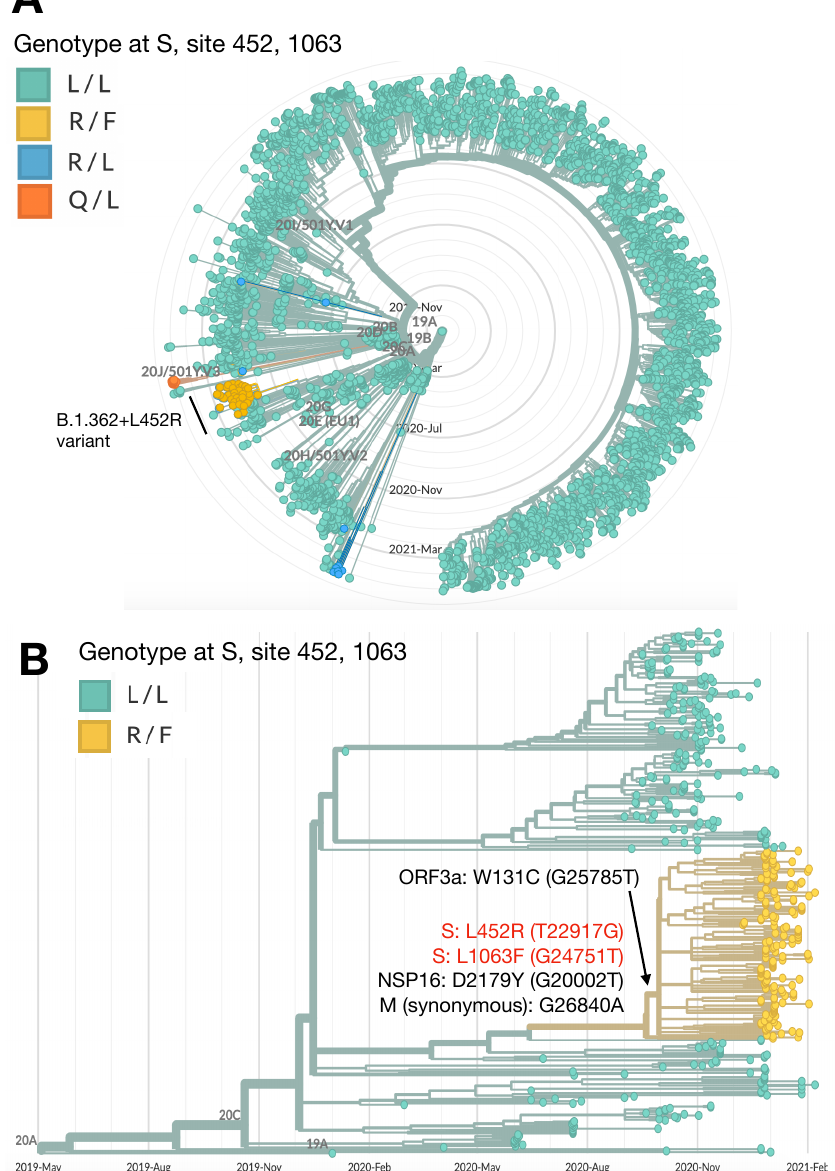
Figure 1. Characterization of the B.1.362+L452R variant in Israel and within the global B.1.362 lineage. ( A ) Phylogenetic tree representing random samples sequenced in Israel from December 2020 to May 2021 ( n = 3870). The genotype at the S protein in locations 452 and 1063 is indicated, with the different amino acid substitutions in these locations denoted by different colors: wild type in green (L/L: positions 452 and 1063 are Leucine (L)) and B.1.362+L452R variant in yellow (R/F: positions 452 and 1063 were substituted to arginine (R) and phenylalanine (F), respectively). Additional variants which have a mutation in the 452 positions are apparent in the tree, including a B.1.617.2 variant cluster with R/L in blue and a C.37 variant cluster with Q/L in orange. ( B ) Global SARS-CoV-2 genomes from of the B.1.362 lineage only ( n = 441). The wide type genotype (L/L) is indicated in green and the B.1.362+L452R variant cluster (R/F) in yellow. The B.1.362+L452R variant cluster is composed of Israeli viruses only. Phylogenetic trees were created with Nextstrain Augur pipeline and visualized with Auspice [26]. Non-Israeli B.1.362 lineage sequences were downloaded from GISAID [25] and identified with Pangolin